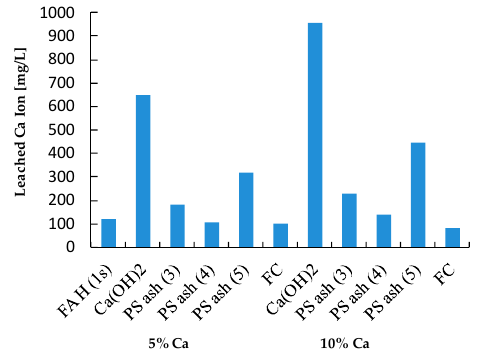
Figure 2. Ca ions leached from fly ash H alone and fly ash H under five kinds of additives for 5% and 10% Ca content samples. Minerals 2017 , 7 , 99